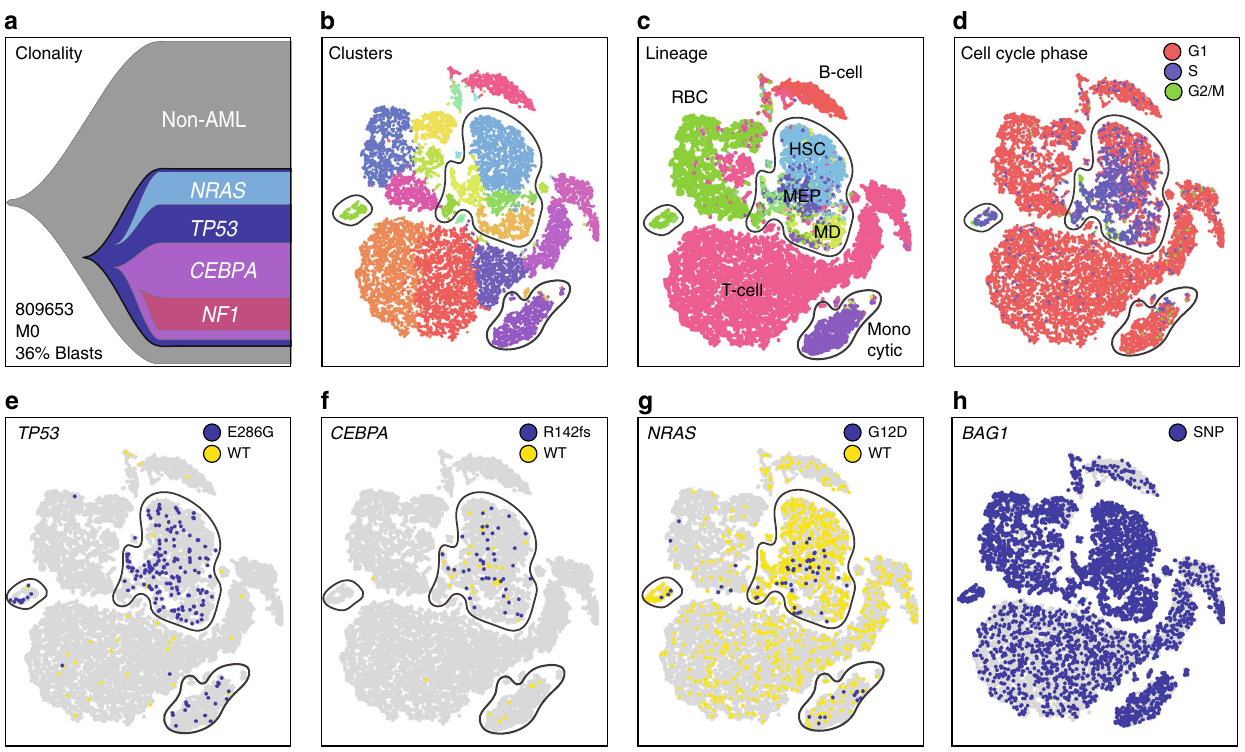
Fig. 3 Single-cell mutation detection and interpretation in case 809653. a Clonality inferred from eWGS, with subclonal driver genes labeled. b t-SNE projection of scRNA-seq data with cells colored according to graph-based cluster assignment. In panels b – g , putative clusters of AML cells are circled. c Cells colored according to inferred lineage; RBC = red blood cell, HSC = hematopoietic stem cell, MEP = myeloid-erythroid progenitor, MD = myeloid dendritic cell. d Cells colored according to cell cycle phase. e – g Cells colored according to single-cell genotype at the TP53 E286G , CEBPA R142fs , and NRAS G12D sites: blue, at least one mutant read detected; yellow, wild-type reads only; gray, no coverage. h Cells colored according to single-cell genotype at the homozygous BAG1 germline SNP: blue, at least one mutant read detected; gray, no